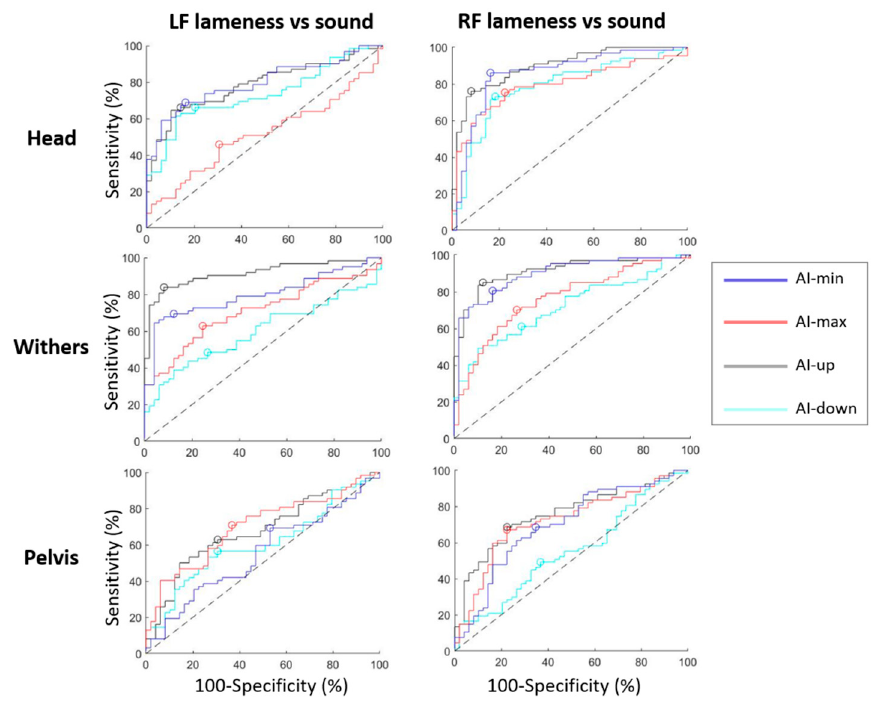
Figure 4. ROC curves discriminating horses with left forelimb (LF) lameness from sound horses; and discriminating horses with right forelimb (RF) lameness from sound horses, plotted for each sensor location (head, withers, pelvis); and plotted for asymmetry indice: AI-min (blue), AI-max (red), AI-up (black) and AI-down (cyan). The best specificity and sensitivity point of each curve is represented by a circle. The dashed black line is the hypothesized ROC curve with discrimination capacity only due to perfect chance. Table 3. Area under the curve (AUC) of the receiver operating characteristic (ROC) curve discrimi- nating sound and forelimb lame horses, for each asymmetry indice (AI). Best sensitivity, specificity, and associated threshold were calculated using top-left method of ROC analysis. [95% confidence interval] were calculated plotting ROC analysis on 400 population resamplings (bootstraps). Results for which the sum of sensitivity and specificity is over 150% for both sides are in bold.